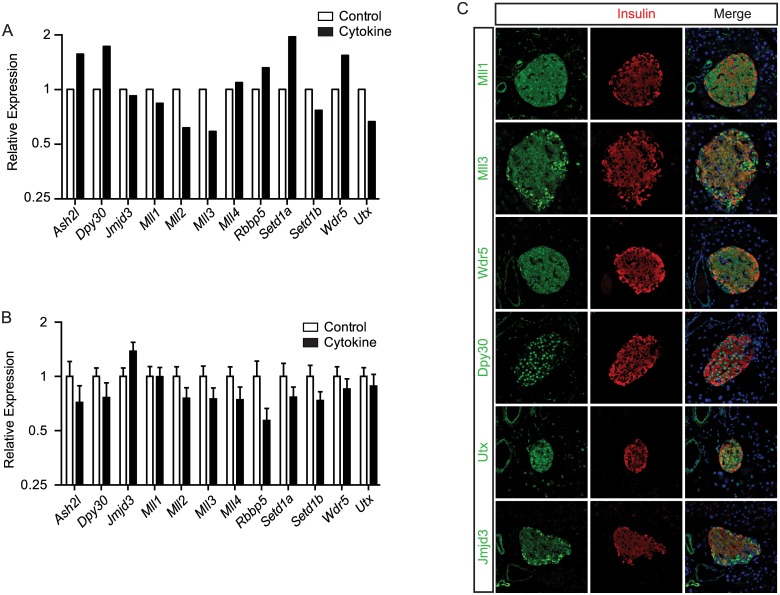
TrxG complex proteins are expressed in adult islet cells and are largely non-responsive to IFNγ, Il-1β, and TNFα exposure.(A) Expression level (FPKM) of the genes for the primary proteins in the TrxG complexes in untreated and IFNγ, Il-1β, and TNFα (cytokine) treated islets. (B) qPCR validation of the unaltered expression of the genes for the primary proteins in the TrxG complexes in IFNγ, Il-1β, and TNFα (cytokine) treated islets as compared to untreated islets. (C) Immunohistochemical co-staining of selected TrxG proteins (green) and insulin (red) in adult pancreas sections. Topro staining (blue) is shown in the merged image to identify nuclei.